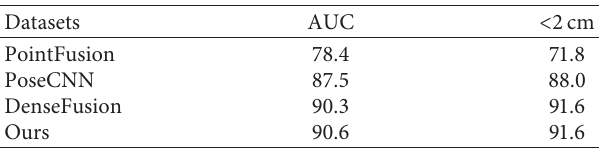
Figure 2: Examples of images from YCB-Video and ShapeNet datasets used for the experiments. Table 1: Quantitative comparison of 6D object pose estimation on the YCB-Video dataset.